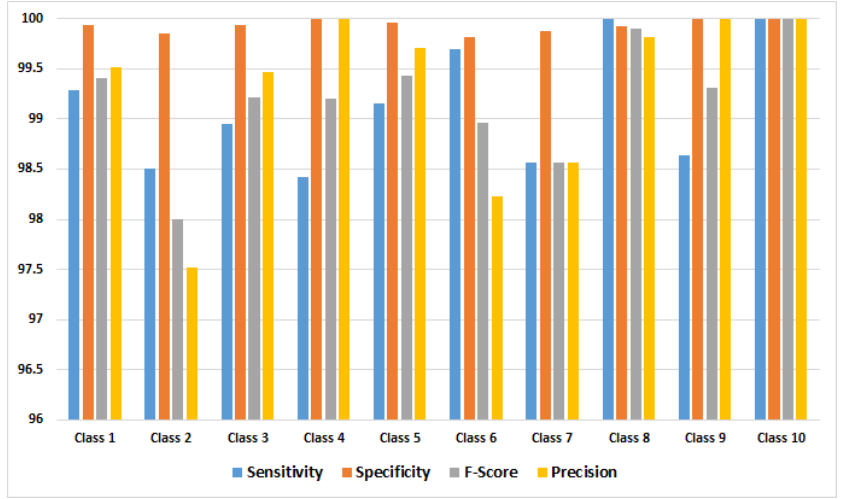
Figure 4. Performance results for each